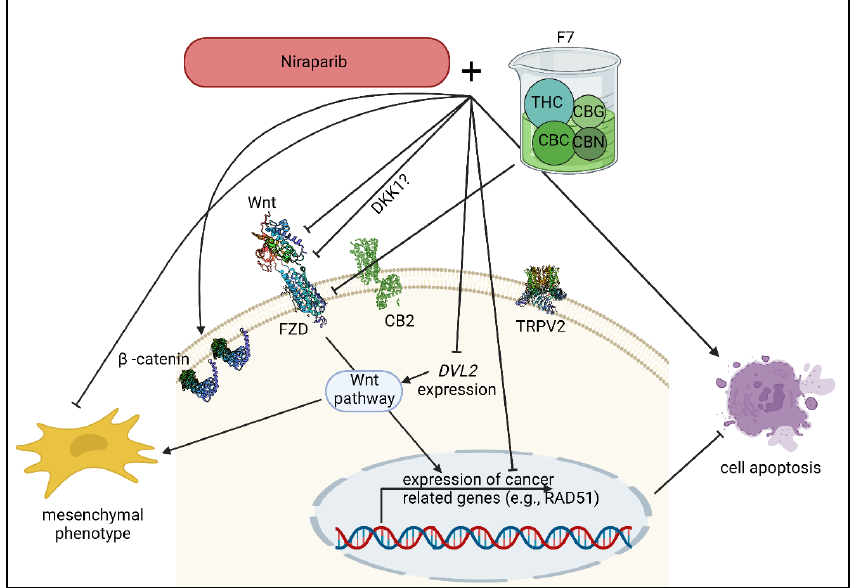
Figure 13. A suggested, simplified model for F7 and niraparib activity in OC cells in relation to the Wnt pathway. F7, niraparib or niraparib+F7 treatments significantly reduced FZD4 and FZD1 expression. This activity for F7 was partially dependent on CB2 activation. The expression of Wnt was altered by the treatments. Treatment with F7 also increased DKK1 expression in one of the examined cell lines. DKK1 inhibited the dimerization of FZD (with LRP5/6 receptor, not shown), directly preventing FZD activation. As a possible result of the alterations of the canonical Wnt signaling pathway, mesenchymal phenotype was inhibited, DVL2 and RAD51 expression was reduced and cell apoptosis was induced. Wnt, wingless/int1; FZD, Frizzled; DKK, Dickkopf; DVL2, Dishevelled2;